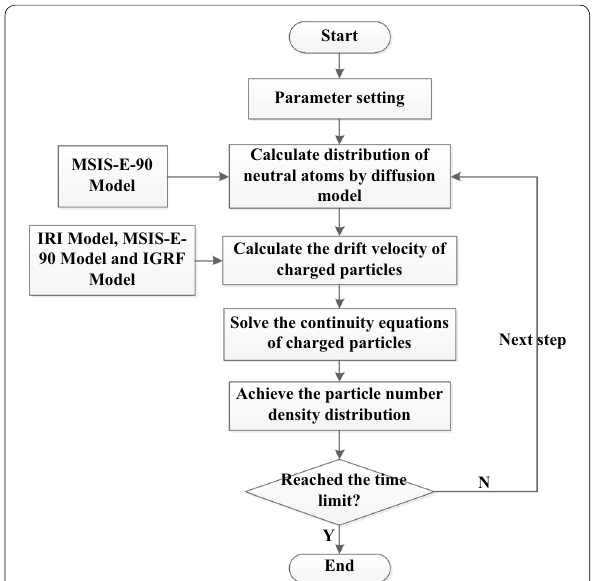
Fig. 1 Flowchart of numerical